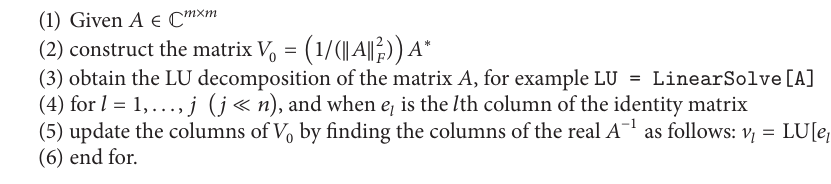
Algorithm 1: An algorithm for constructing a rapid and robust initial approximation for 𝐴 −1